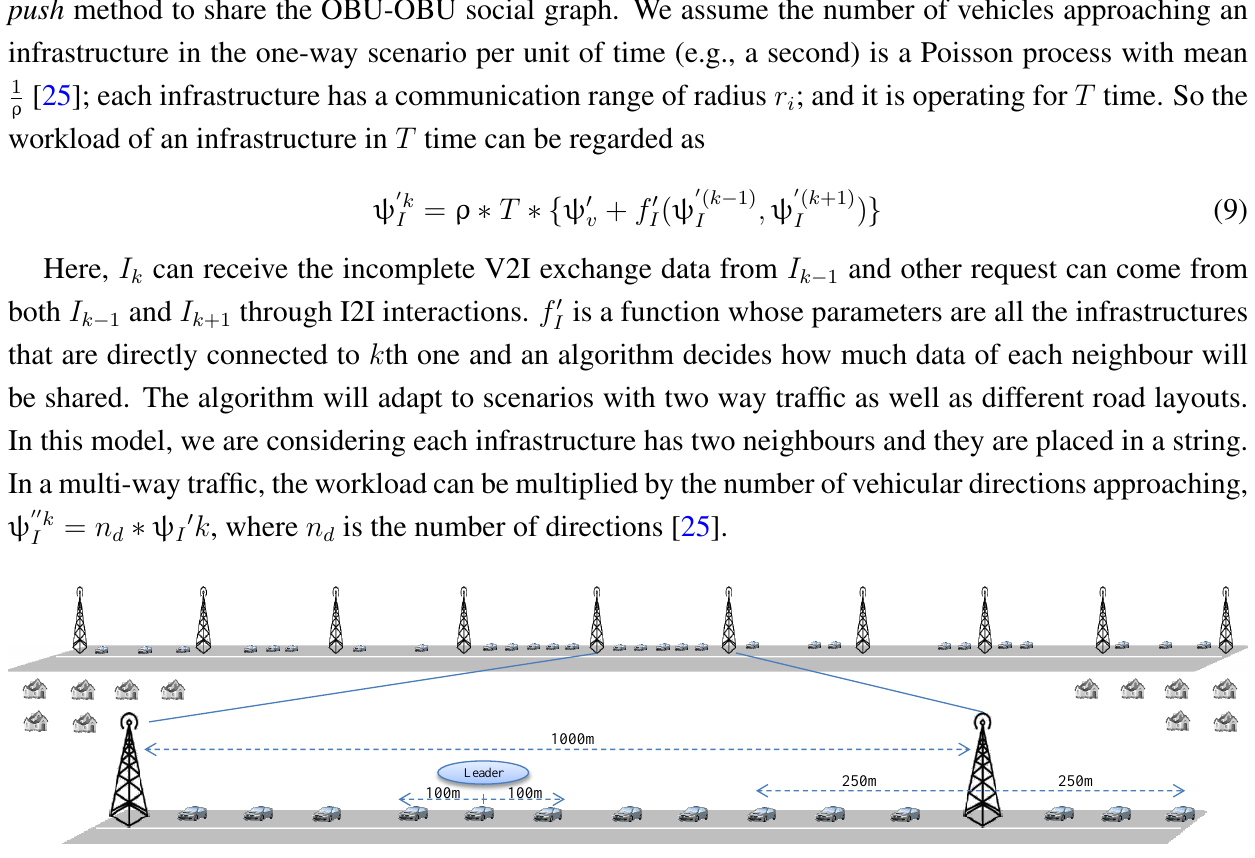
Figure 8. A detailed scenario setup of the extended